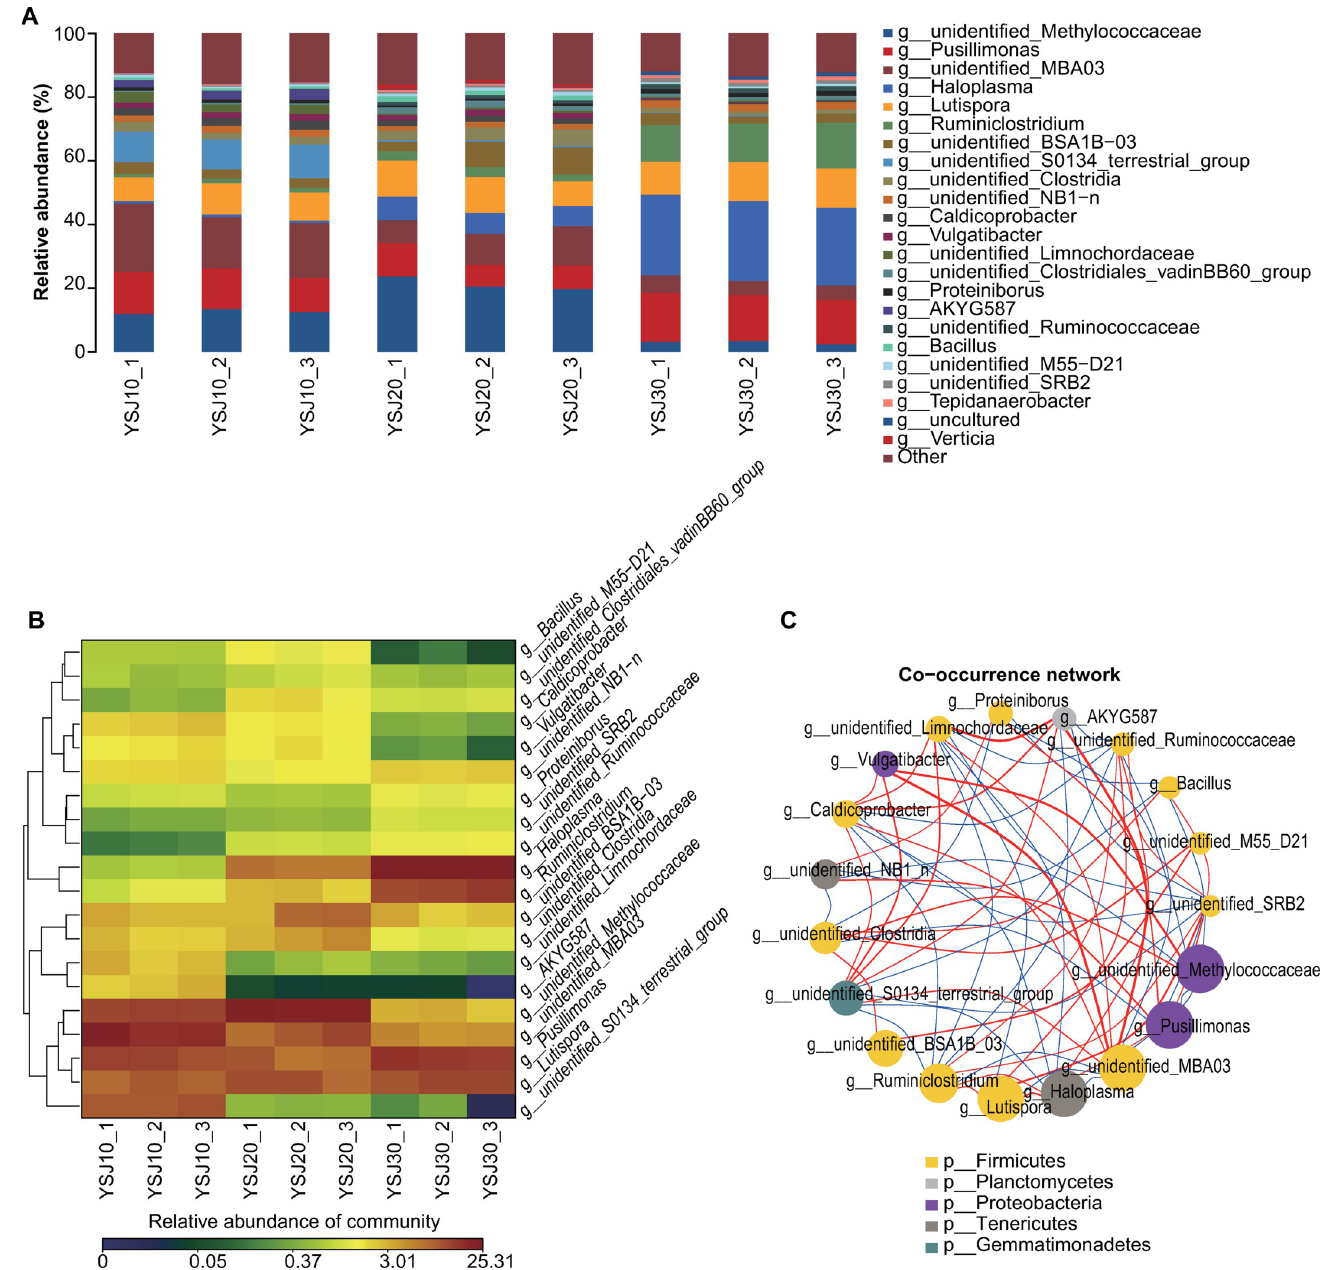
Fig 2. Taxonomic comparison of YSJ samples at the genus level. (A) Relative abundance of the 23 most abundant bacterial genera detected in the YSJ samples. (B) Heatmap of the distribution of the relative abundance of the genera present in the YSJ samples. Columns list genera with relative abundances greater than 1% and are clustered according to phylogenetic relationships. Significance: NS p > 0.05, � p � 0.05, �� p � 0.01. (C) Network of the co-occurring 90% cutoff operational taxonomic units based on correlation analysis. A connection represents a strong and significant ( p -value < 0.01) correlation. The size of each node is proportional to the number of